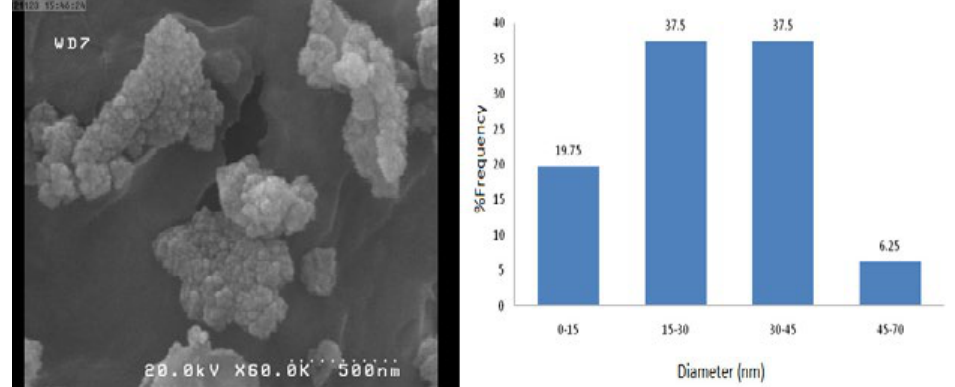
Fig. 12. SEM image and the corresponding particle size distribution histogram of NiO nano-particles prepared by calcination of nano-powder of compound 2 at 450 ºC